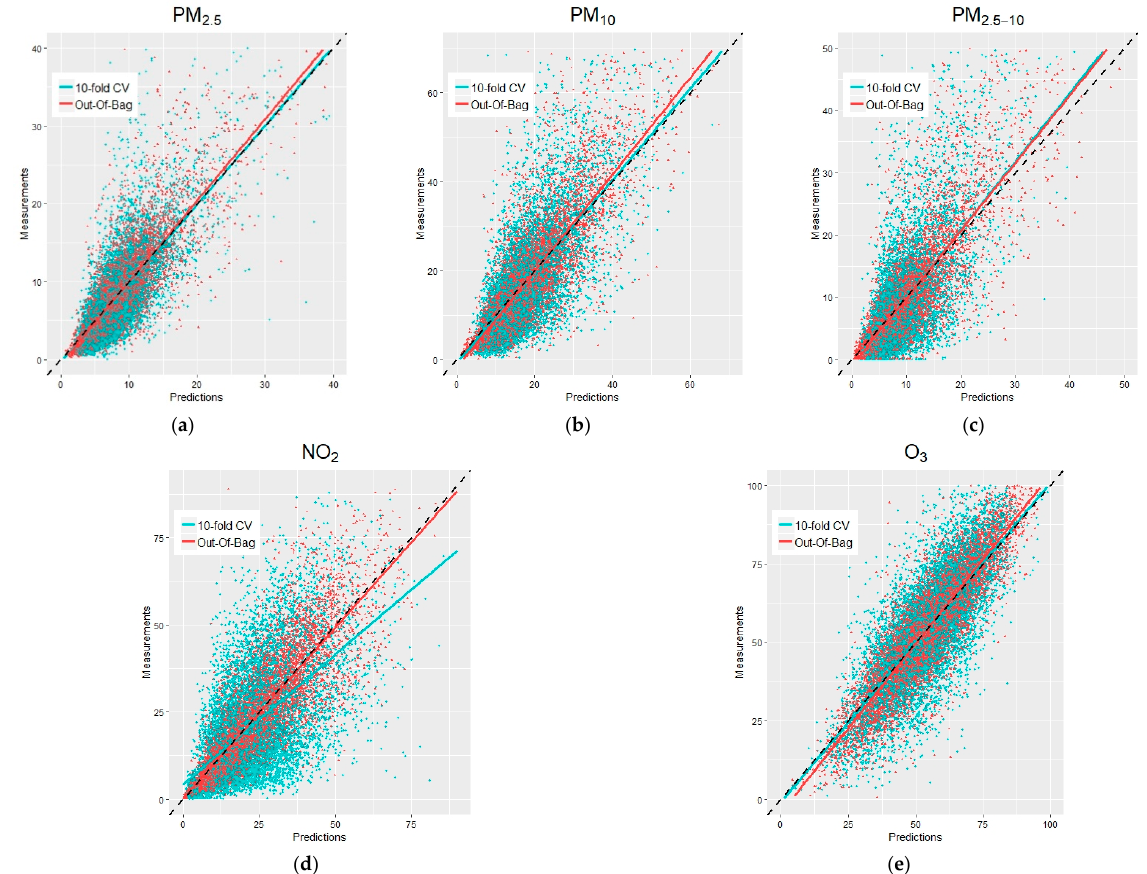
Figure 2. Results of the stage 3 model* for the five pollutants, PM 2.5 ( a ), PM 10 ( b ), PM 2.5 ‐ 10 ( c ), NO 2 ( d ), and O 3 ( e ): measurements and predictions from “out ‐ of ‐ bag” (OOB) samples and 10 ‐ fold cross ‐ validation by monitors. * Measurements ( y ‐ axis) vs. predictions ( x ‐ axis). The red and light blue lines represent the univariate regression lines between measurements and predictions in OOB samples or left ‐ out monitors, respectively. Measurements are displayed on the y ‐ axis as the purpose of the plot is to show how much variability in observations is captured, and how much bias introduced, by predictions.